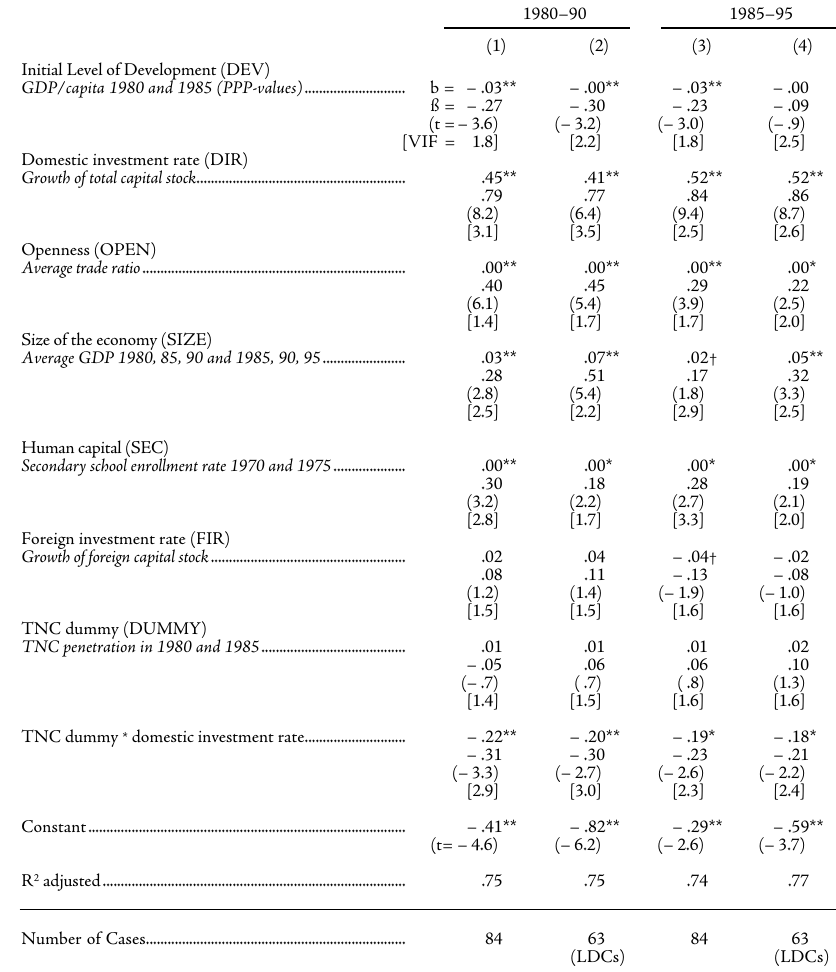
Table 2 – Dependent Variable: GDP per capita growth; OLS